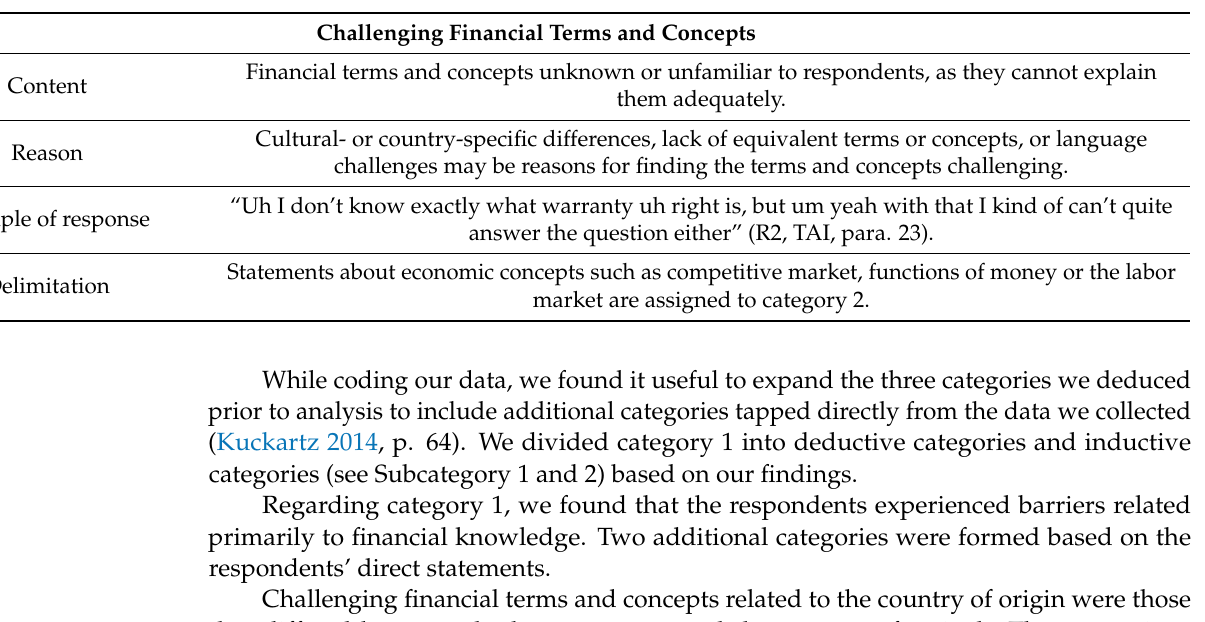
Table 3. Definition of Category